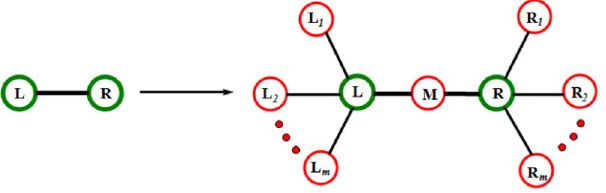
Figure 3. Illustration showing the relation of the trapping times for new nodes and old nodes connected by an edge generating the new